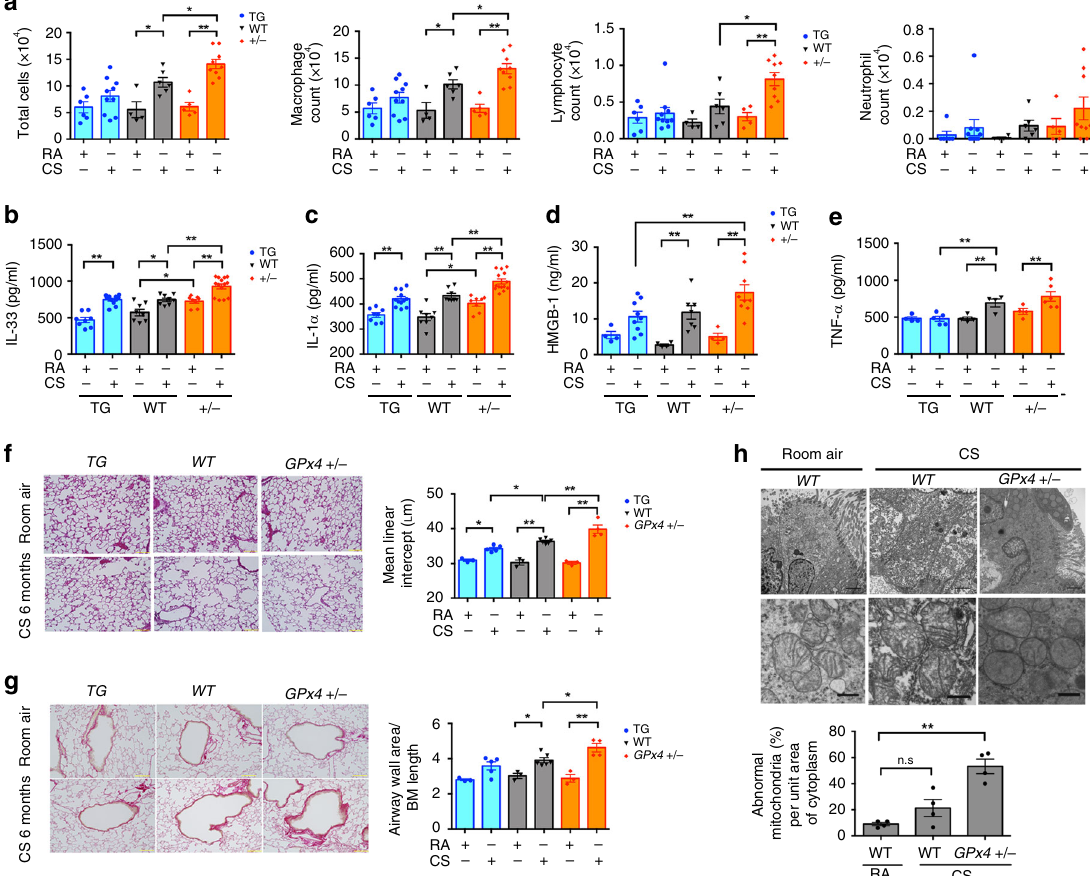
Fig. 4 GPx4 modulates COPD phenotype in smoking mouse models. a – e GPx4 + / − , GPx4 + / + (WT), and TG(loxP-GPx4):GPx4 + / + (GPx4TG) mice were exposed to RA or CS for 4weeks. a Cell counts of total cells, macrophages, lymphocytes, neutrophils in bronchoalveolar lavage fl uid (BALF) from RA or CS exposed mice. n = 6(mice) in TG-RA(TR), n = 10 TG-CS(TC), n = 4 in WT-RA(WR), n = 6 in WT-CS(WC), n = 5 in GPx4 + / − RA (GR), n = 9 in GPx4 + / − CS(GC). b ELISA assay of IL-33 ( n = 8 in TR, n = 12 TC, n = 8 in WR, n = 8 in WC n = 8 in GR, n = 14 in GC), c IL-1 α ( n = 8 in TR, n = 12 TC, n = 8 in WR, n = 8 in WC, n = 8 in GR, n = 14 in GC), e TNF- α ( n = 4 in TR, n = 5 TC, n = 4 in WR, n = 4 in WC, n = 4 in GR, n = 6 in GC), d in lung homogenate in